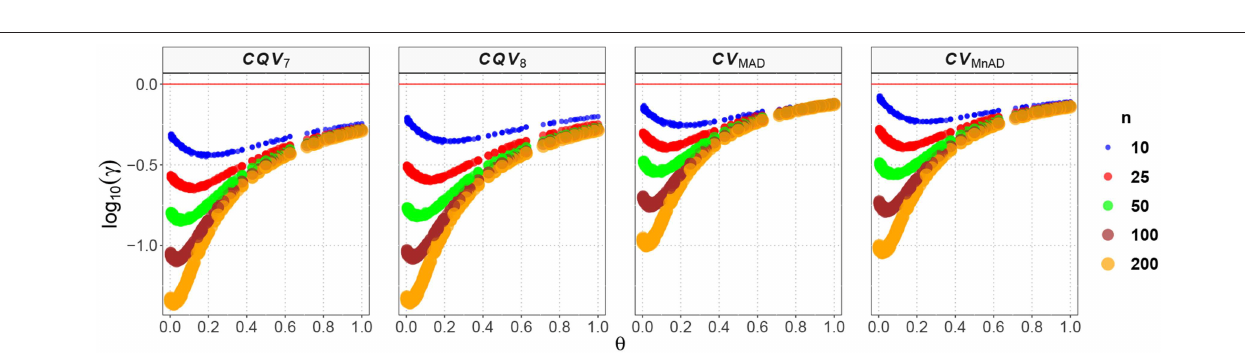
FIGURE 8 | Scatter plots comparing the log 10 ( γ ) accuracy metric as a function of θ Shifted-Exponential distribution.